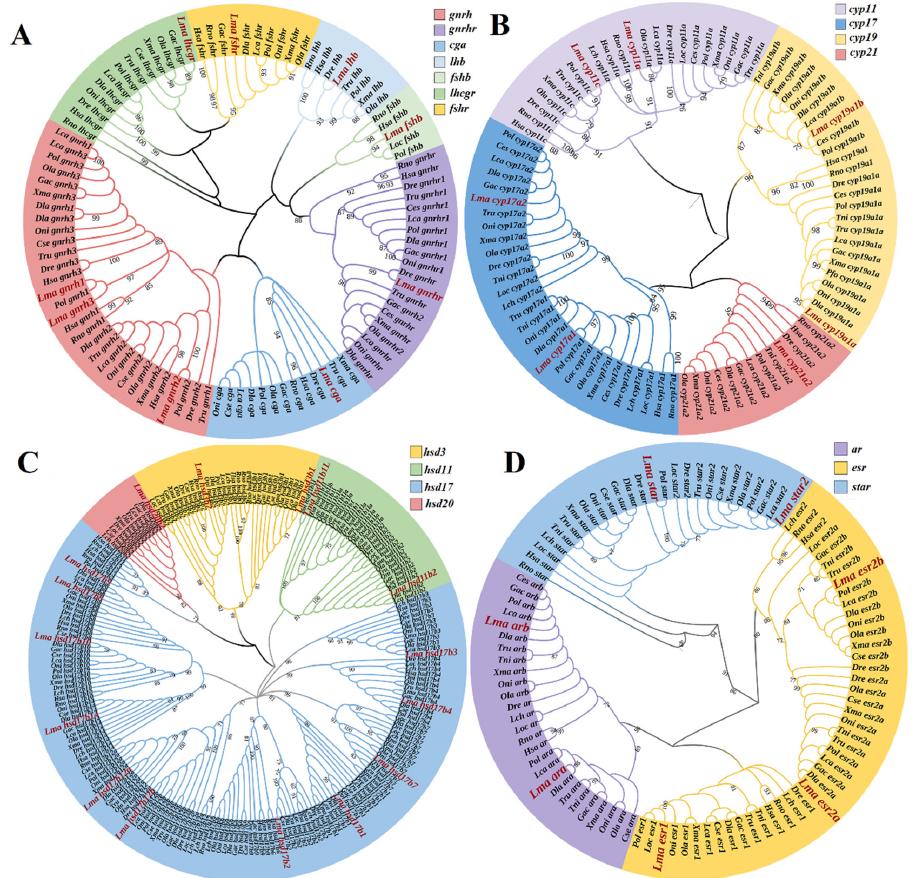
Figure 2. Phylogeny of the HPG axis genes among vertebrates. ( A ) Genes mainly present in the hypothalamus and pituitary ( gnrh , gnrhr , cga , lhb , fshb , lhr, and fshr ). ( B ) The cyp gene family. ( C ) The hsd gene family. ( D ) The star , ar , and esr genes. Colored ranges represent different gene classes. The L. maculatus HPG axis genes are shown in red font, enlarged italics, and bold.